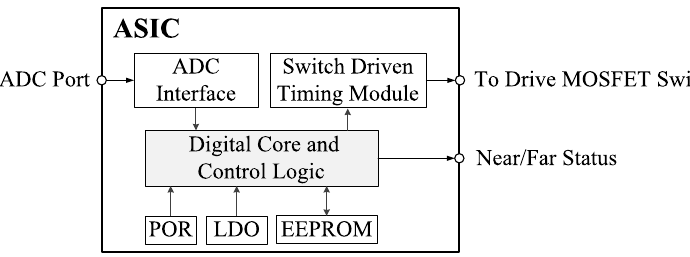
Figure 7. Functional block diagram of the ASIC (AD mixed CMOS integrated